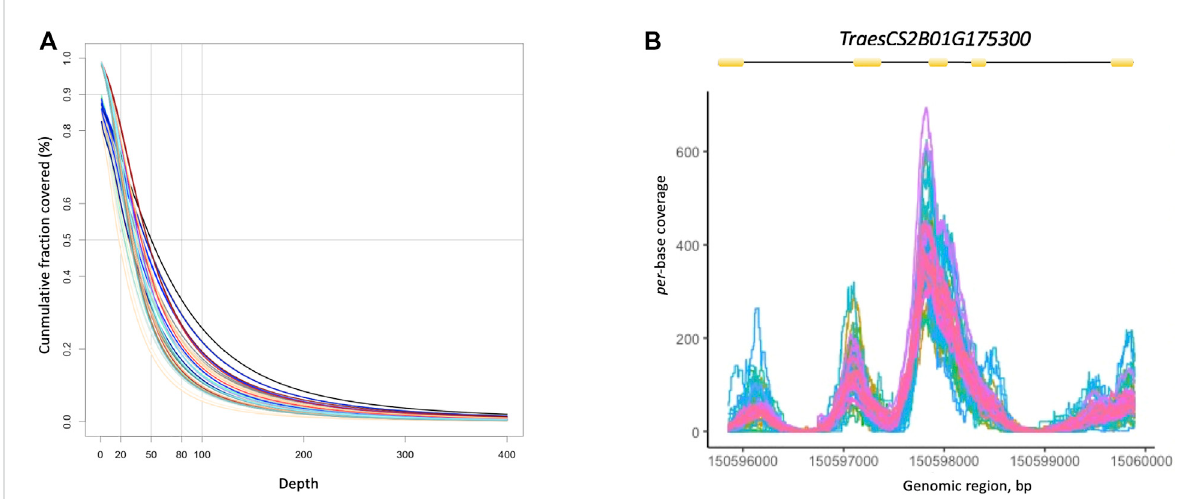
FIGURE 1 (A) Cumulativedistributionofcoveragedepthacrosstargetregionin48wheatindividuals.Thegraphhighlightsthefractionofbasescapturedin the target regions covered at a depth ranging between 0x – 400x. (B) Per-base depth of coverage for the TraesCS2B01G175300 gene in all individuals. The exon (yellow boxes) -intron (black lines) gene structure is shown above the multi-line